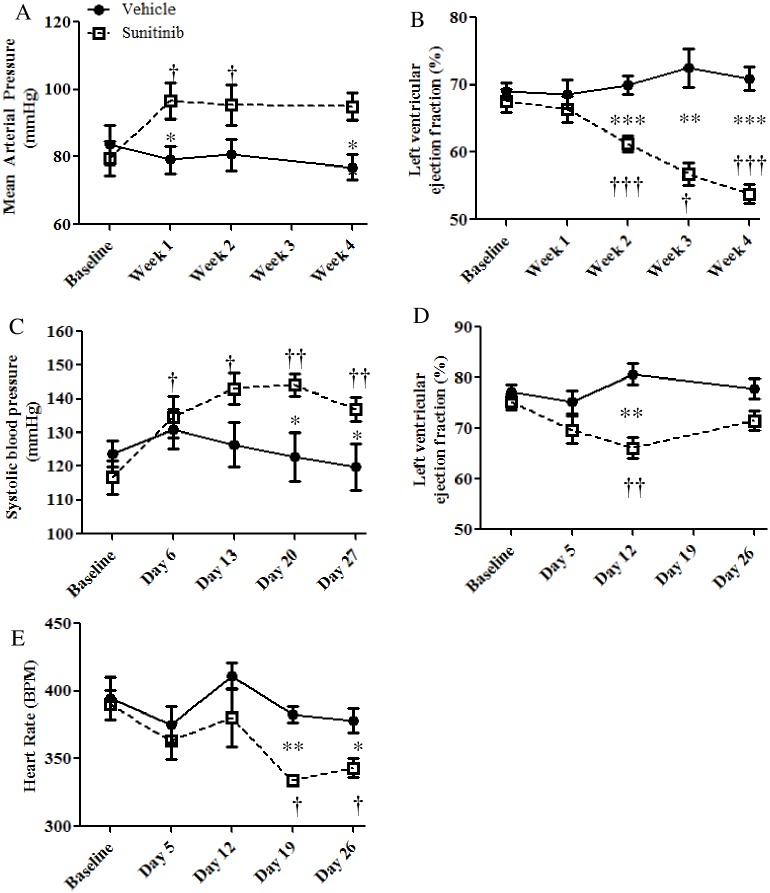
Physiological effects of sunitinib in two rodent models.Effects of sunitinib treatment on MAP (A, n = 9/group) and LVEF (B, n = 13/group) in female Balb/CJ mice. D-E) Effect of sunitinib treatment on systolic blood pressure (C), LVEF (D) and heart rate (E) in female Sprague-Dawley rats (n = 6/group, Significant difference between groups (unpaired t-test, *p<0.05 **p<0.01 ***p<0.001), Significant change from pre-treatment values (paired t-test, †p<0.05 ††p<0.01 †††p<0.001). Error bars = SEM)